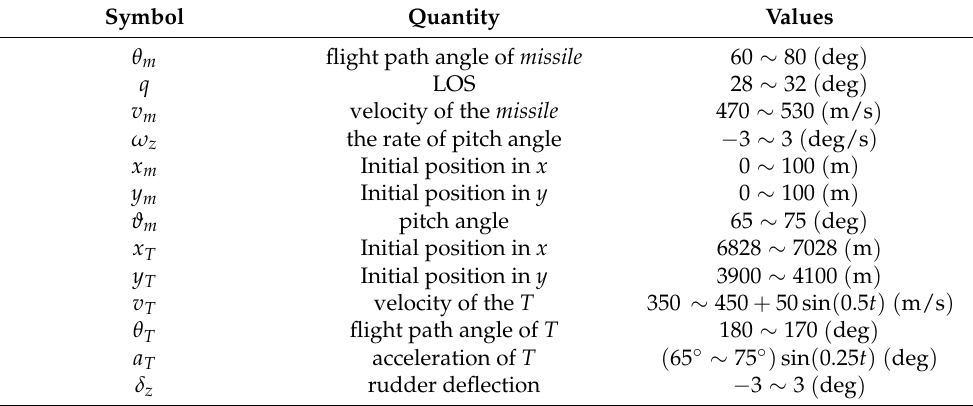
Table 4. The Monte Carlo parameters under case III.